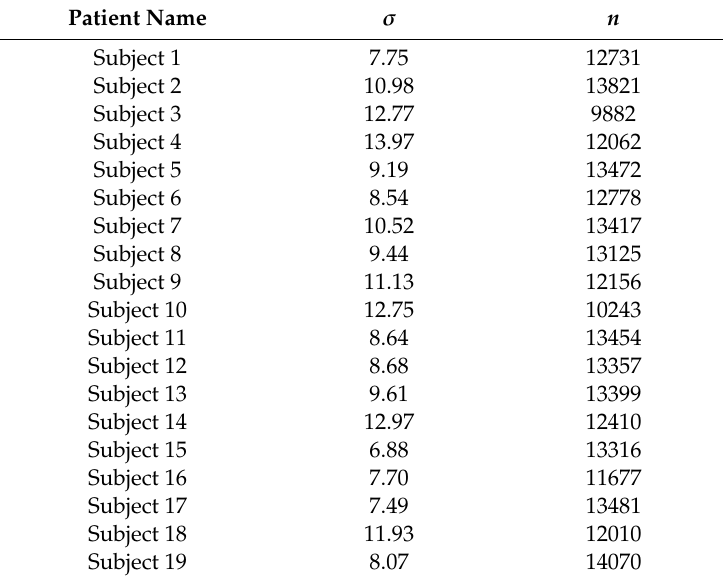
Figure 9. Modeled distribution functions of the patients. Table 2. Estimated variance and data number used in stochastic modeling.